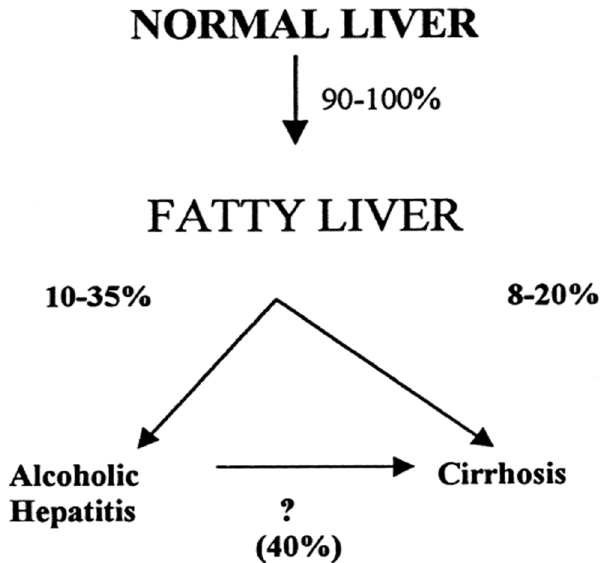
Figure 22. Development of alcoholic cirrhosis Good evidence exists that alcoholic hepatitis is responsible for most cases of alcoholic cirrhosis, but it may emerge also from alcoholic fatty liver with its perivenular and perisinusoidal fibrosis. Symbol: ?, pathway under discussion. The figure was published in a previous report [345], and is reproduced with permission of the Publisher Springer (Berlin, Germany).